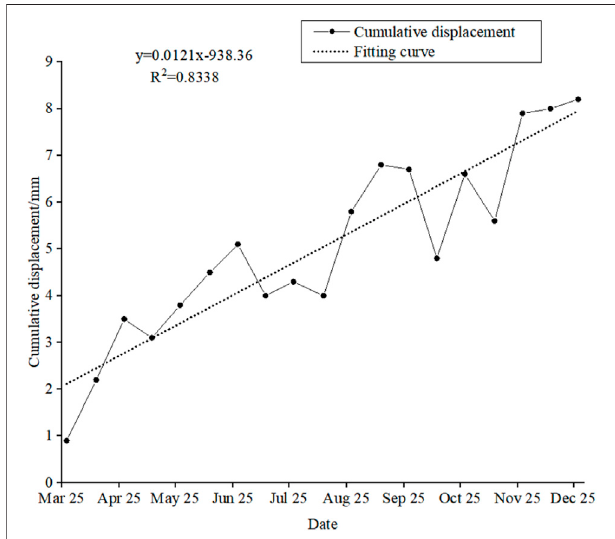
FIGURE 3 | Surface displacement of GPS-02 monitoring point in